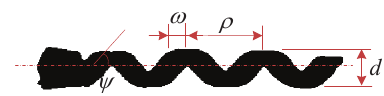
Figure 8. Microswimmer geometry: pitch length ρ = 4 mm, diameter d = 1.5 mm, ω = 1.2 mm, ψ = 36.87 ◦ .